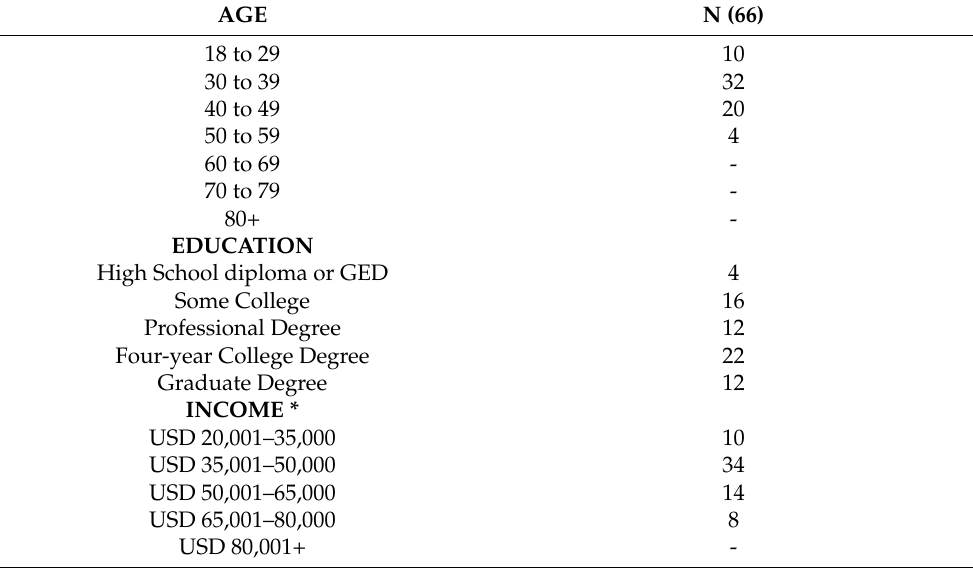
Table 1. Demographic-related information for